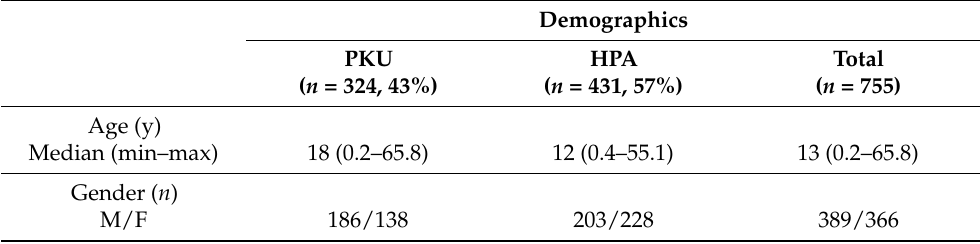
Table 1. Demographic characteristics of PKU/HPA population screened and reviewed for study